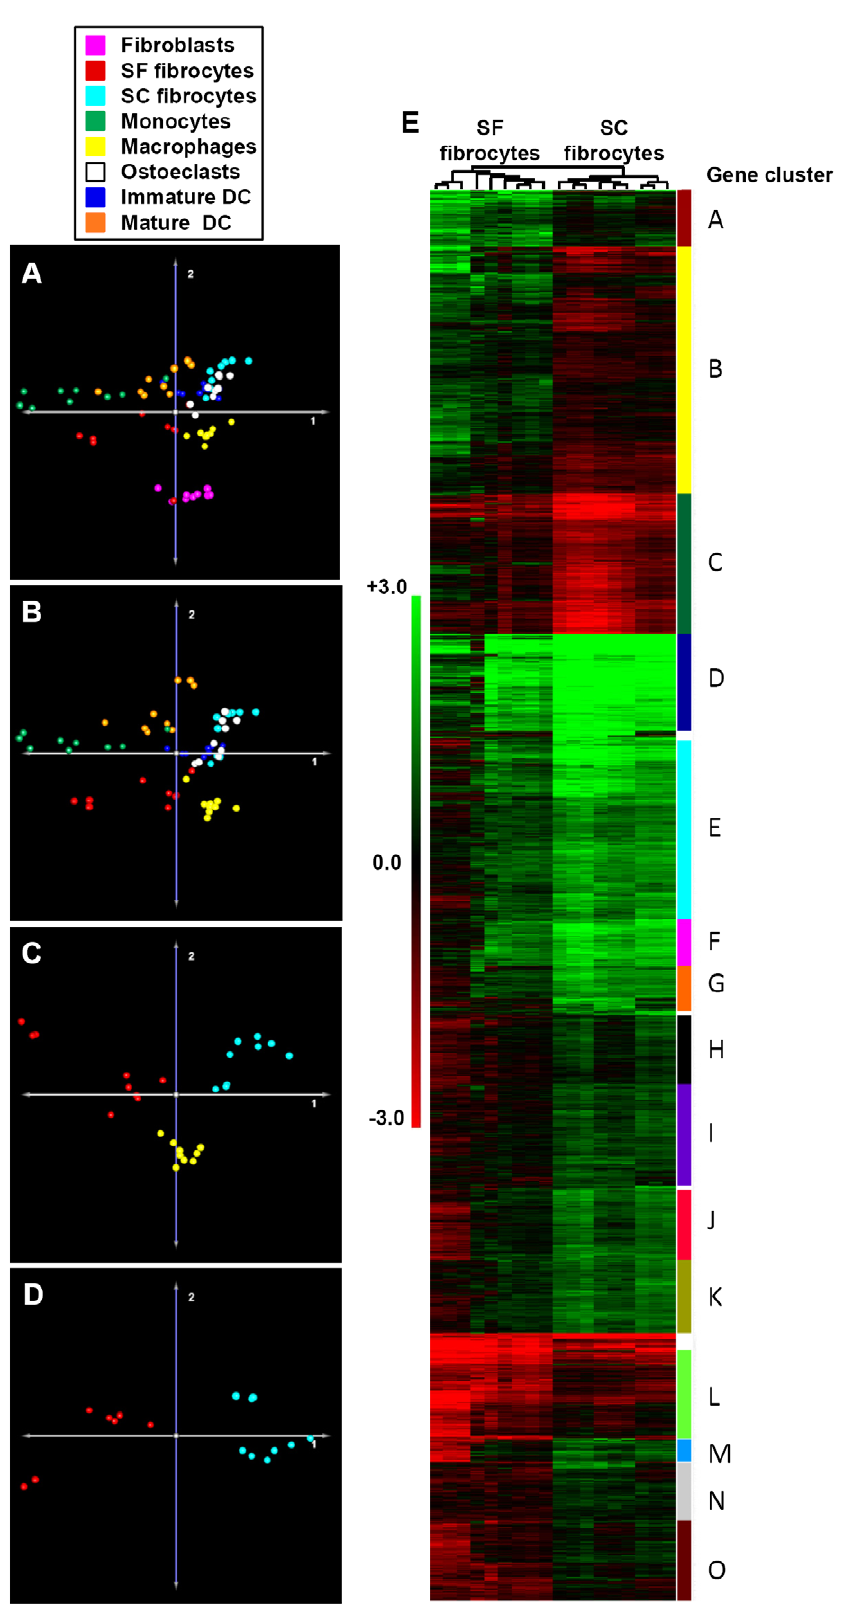
Figure 4. Fibrocytes generated in serum-free and serum-containing conditions show distinct transcriptional profiles from each other, as well as other monocyte-derived progeny. The expression of 35,788 genes was determined by gene microarray analysis for fibroblasts,